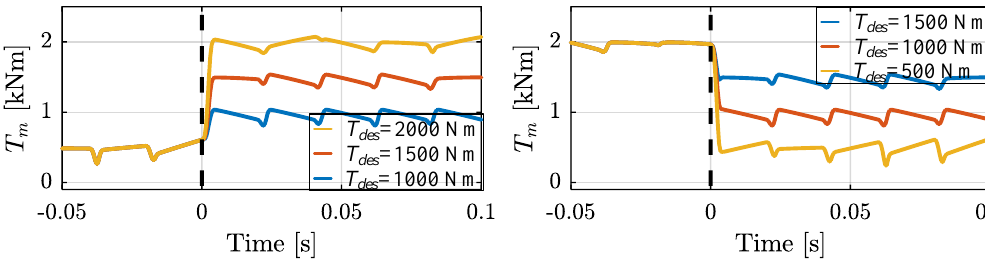
Figure 24. Step-up response ( left plot ) and step-down response ( right plot ) using SPSDS in the time